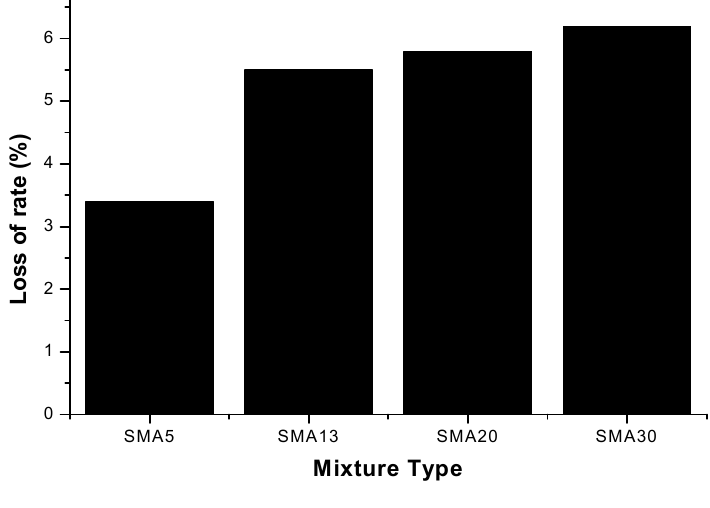
Figure 4 . Mixture type and loss of rate. Figure 4. Mixture type and loss of